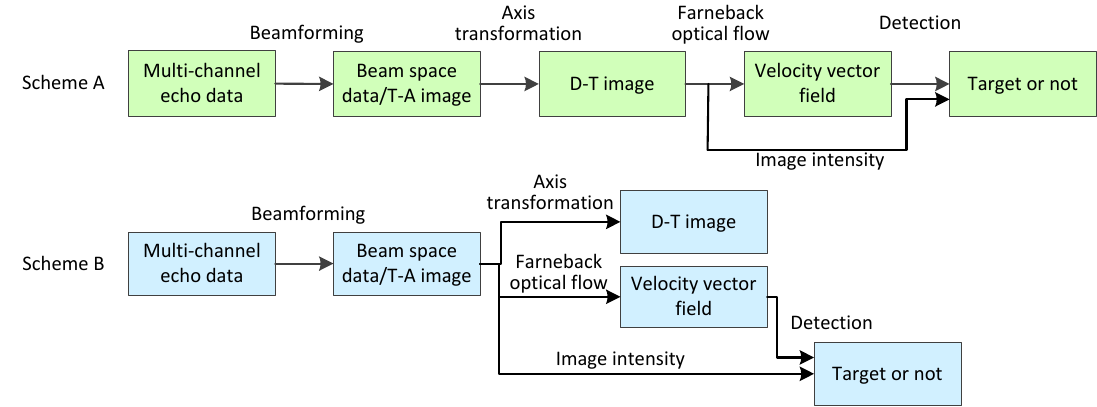
Figure 2. Two types of data processing schemes in motion estimation of gas emissions.